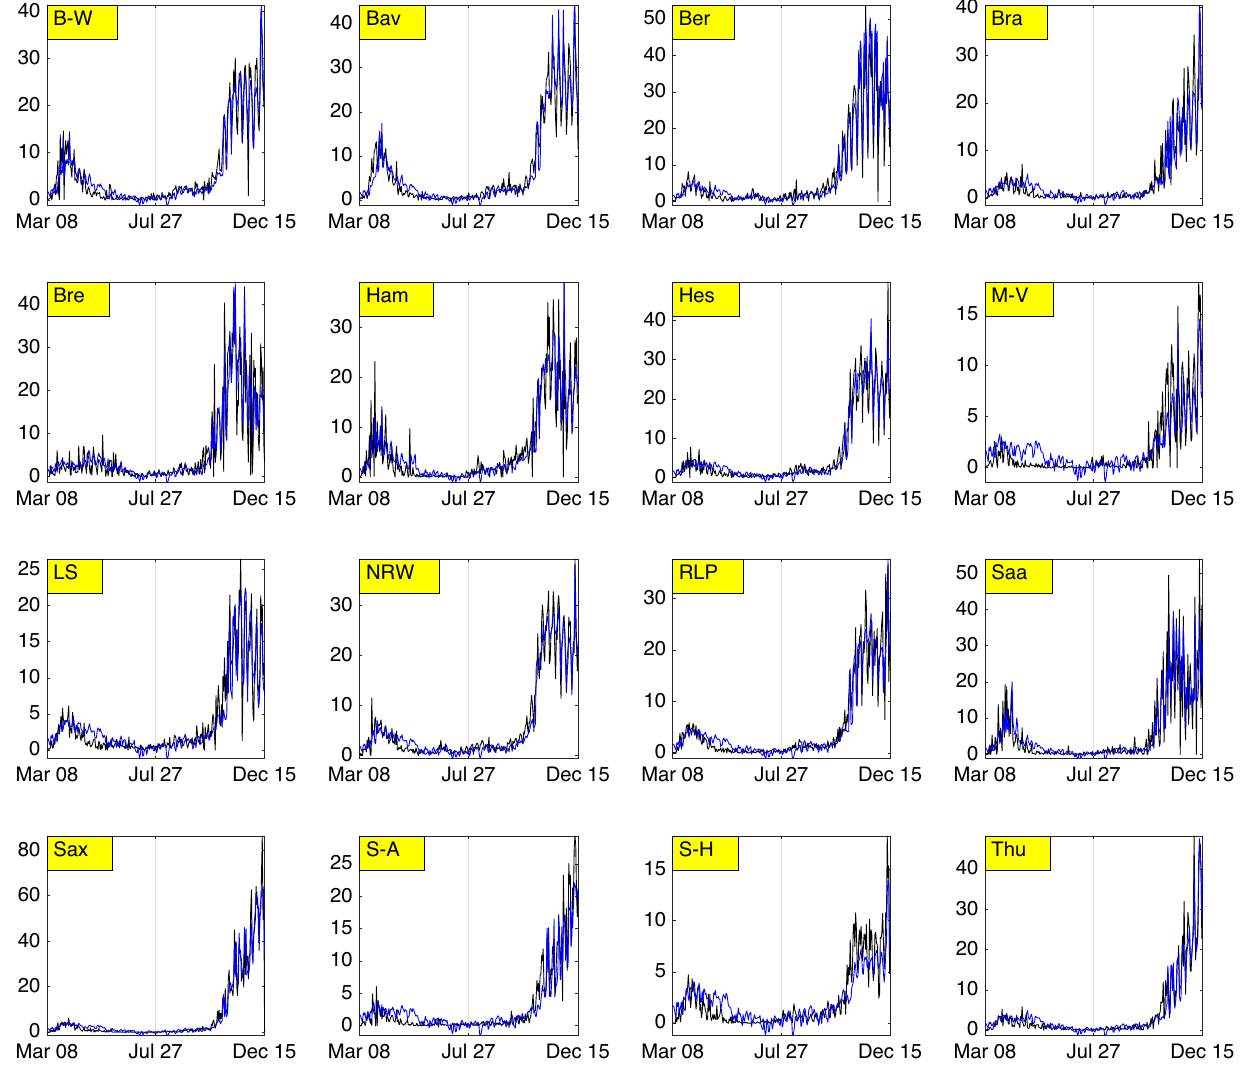
Figure 8. Fitting result (in blue) for the model including incidence